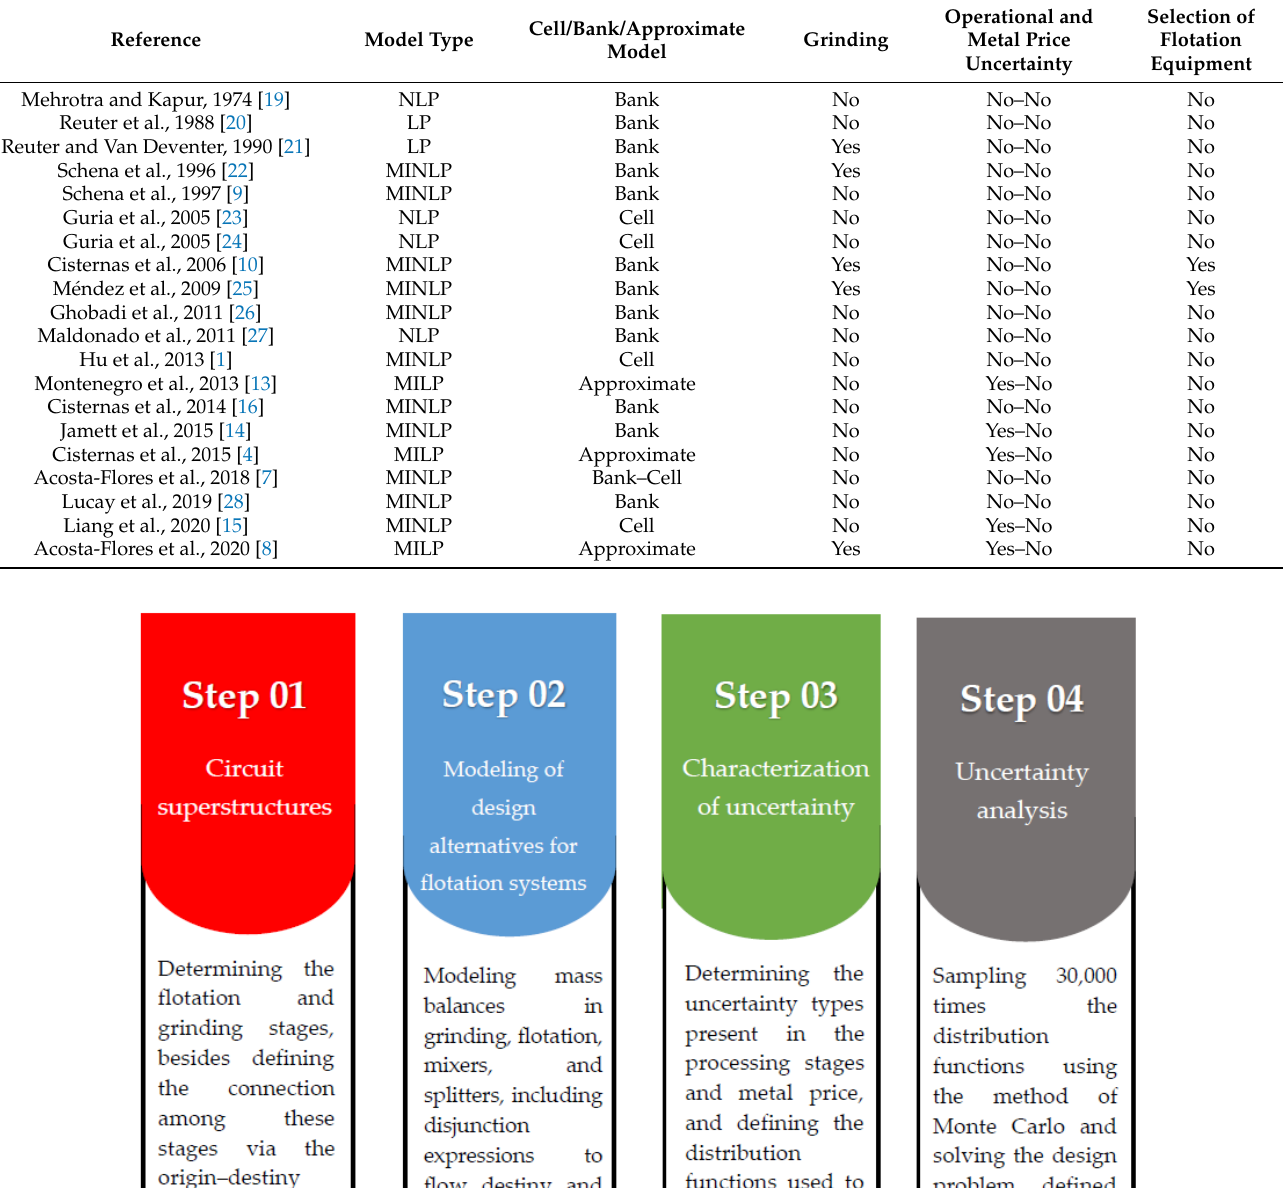
Table 1. Flotation system design methodologies, NLP = nonlinear programming, LP = linear programming, and MINLP = mixed integer nonlinear programming. Uncertainty described by distribution functions.